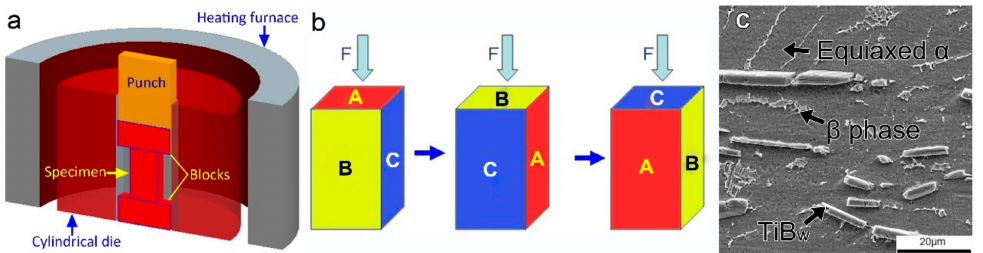
Figure 1. ( a , b ) Schematic illustration of multi-directional forging process; ( c ) SEM micrograph of